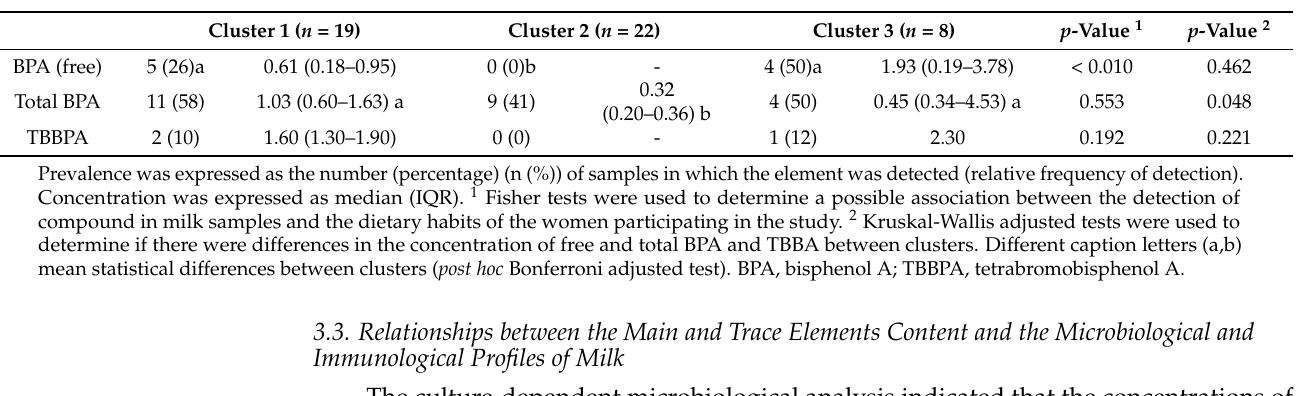
Table 3. Frequency and concentration (expressed as µ g/L) of TBBPA, free and total BPA in the milk samples depending on the dietary habits of the women participating in the study ( n =